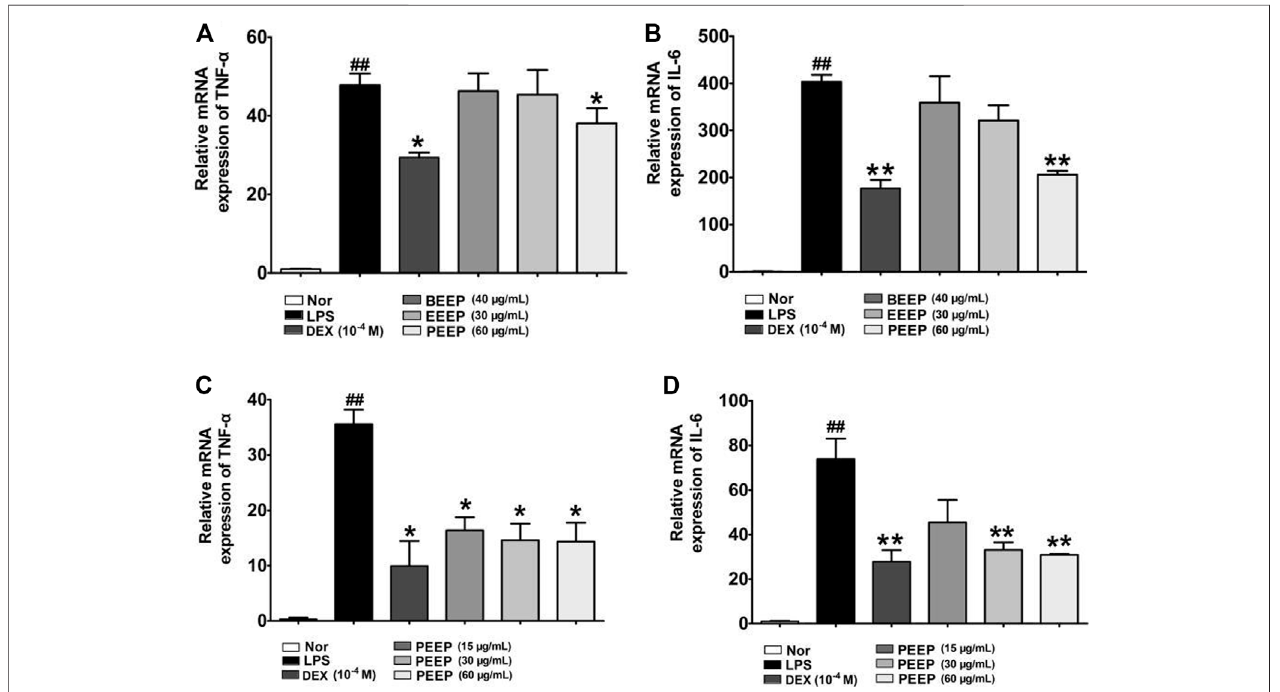
FIGURE 3 | Effect of PEEP, EEEP and BEEP on the expressions of in fl ammatory factors in RAW264.7 macrophages induced by LPS. (A) The effect of PEEP (60 μ g/ml),EEEP(30 μ g/ml)orBEEP(40 μ g/ml)onmRNAexpressionsofTNF- α weredetectedusingQ-PCRassays. (B) TheeffectofPEEP(60 μ g/ml),EEEP(30 μ g/ml) or BEEP (40 μ g/ml) on mRNA expressions of IL-6 were detected using Q-PCR assays. (C) The effect of PEEP (15, 30 and 60 μ g/ml) on mRNA expressions of TNF- α weredetectedusingQ-PCRassays. (D) TheeffectofPEEP(15,30and60 μ g/ml)onmRNAexpressionsofIL-6weredetectedusingQ-PCRassays.Thedatawere expressed as the means ± S.E.M. of three independent experiments. ## p < 0.01 vs. Normal group; * p < 0.05, ** p < 0.01 vs. LPS